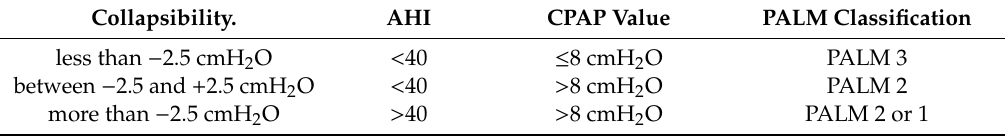
Table 2. Relation between collapsibility, AHI, CPAP value, and PALM classification. Collapsibility. PALM Classification